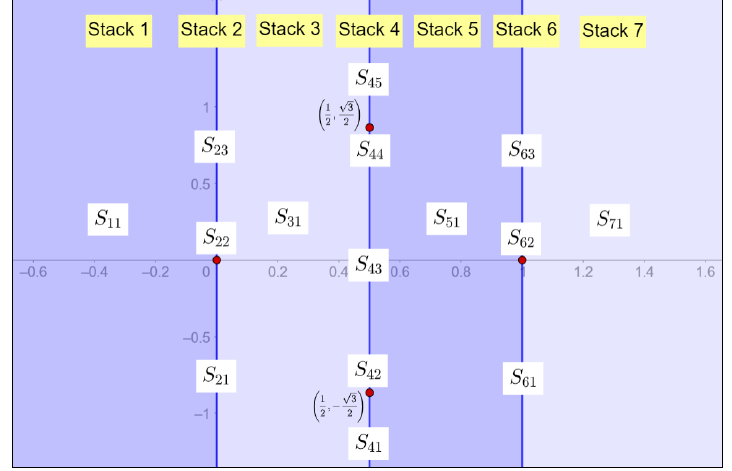
Figure 15. CAD compatible with the set of solutions of P ( x , y ) =